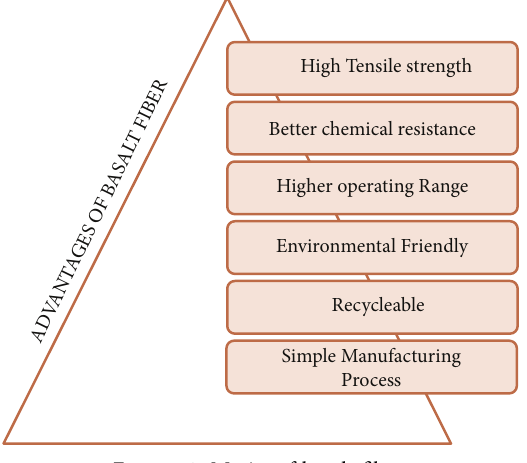
Figure 1: Merits of basalt